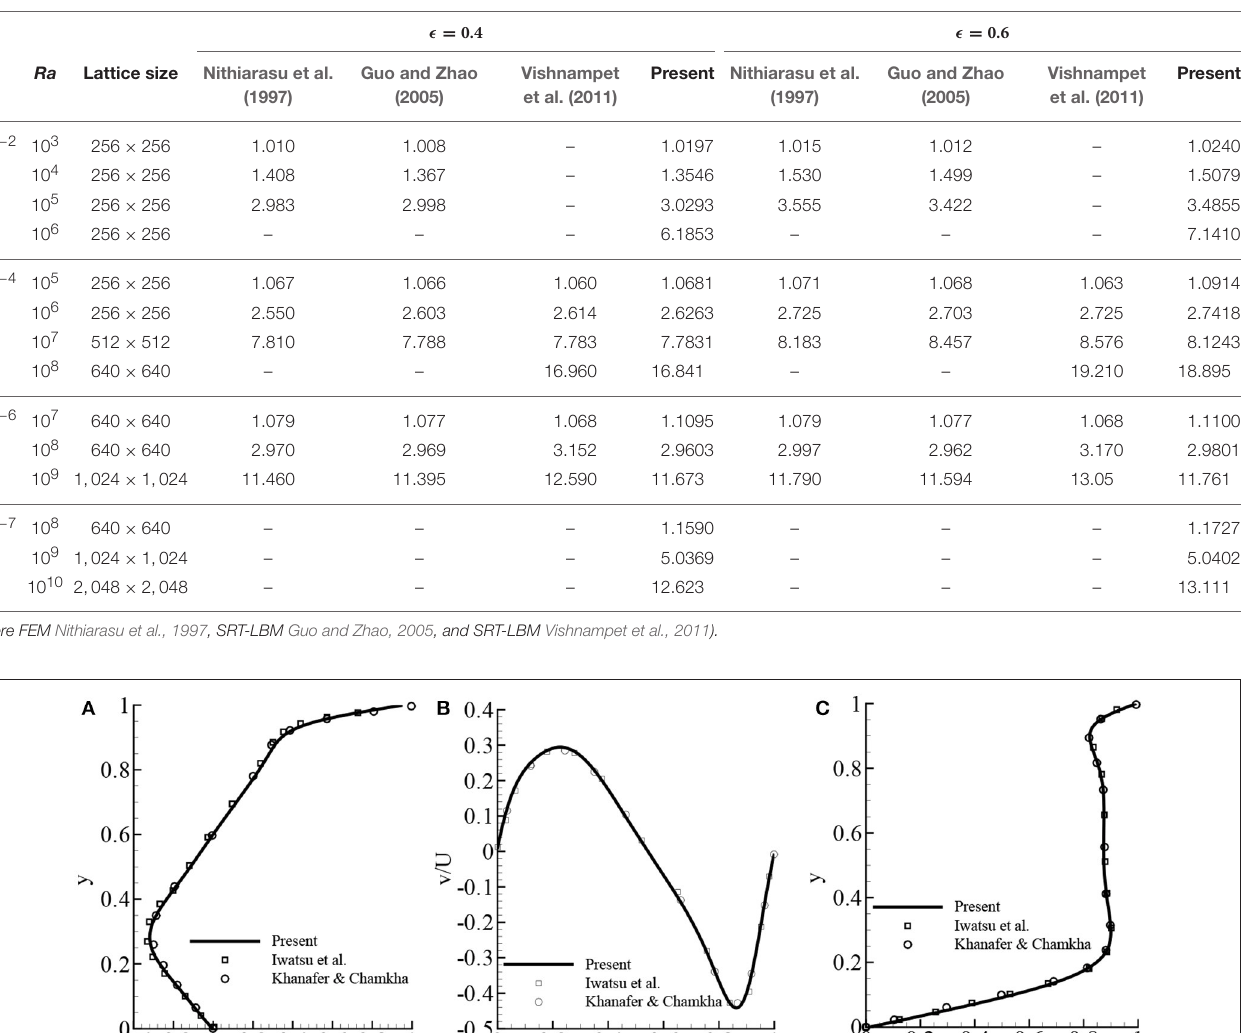
TABLE 4 | The average Nusselt number, Nu , with the Brinkman–Forchheimer model for Pr =1.0.